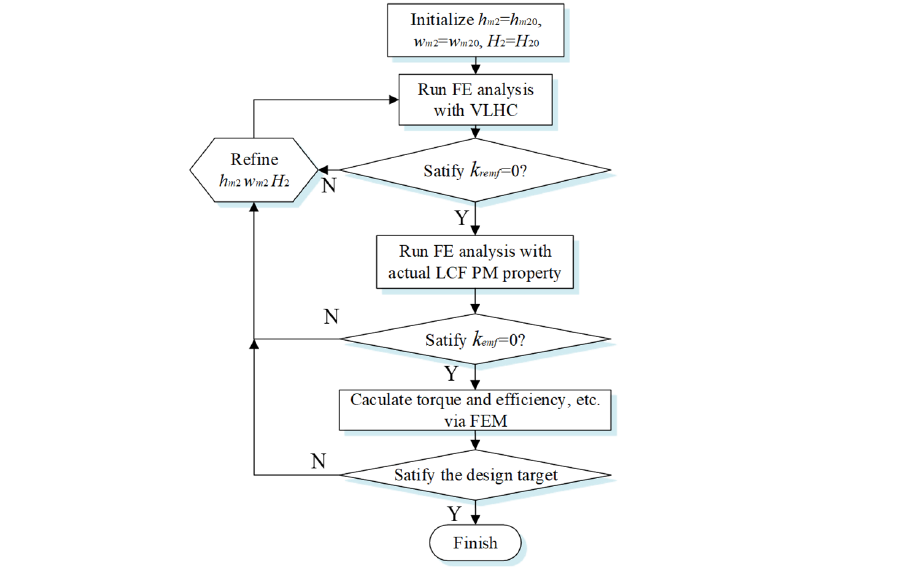
Figure 13. Flowchart of the procedure of the magnet optimization.